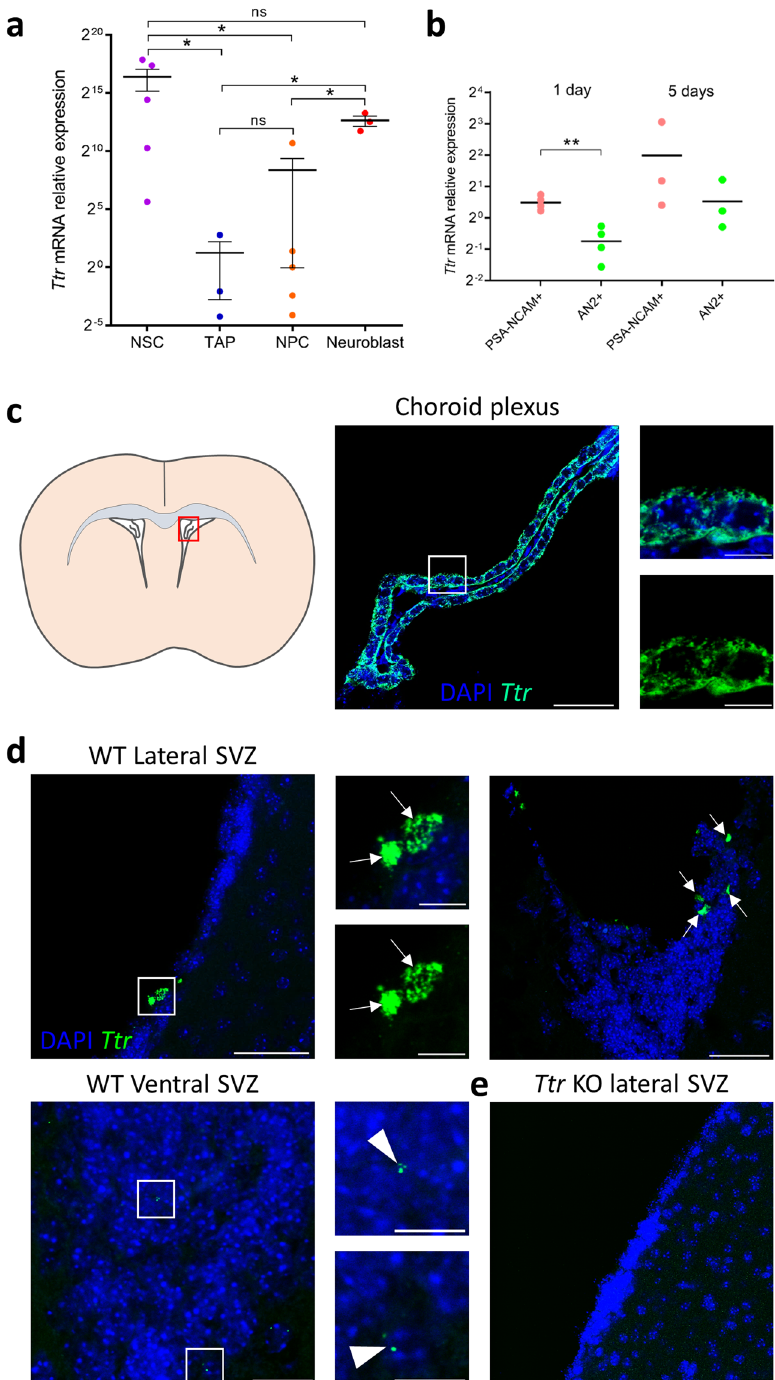
Figure 5. Detection of Ttr mRNA expression in SVZ cells. ( a ) Ttr mRNA expression levels in FACS-sorted SVZ cells. High Ttr levels were found in quiescent and activated NSCs (CD133 + ), after which they dropped in TAPs (EGFR + ) and NPCs (EGFR + CD24 + ). Cells committed to the neuroblast lineage (CD24 + ) showed increased Ttr expression levels (n = 3–5, Kruskal Wallis ANOVA followed by Mann-Whitney U tests). ( b ) Ttr mRNA expression levels were measured in magnetic bead-sorted neuronal (PSA-NCAM + ) and oligodendroglial (AN2 + ) cells after 1 and 5 days of in vitro differentiation. Ttr mRNA levels were significantly higher in neuronal cells after 1 day of in vitro differentiation (n = 3–4, two-tailed Student’s T tests). ( c ) Visualisation of Ttr mRNA transcripts in choroid plexus epithelial cells (red box on the schematic section) using RNAscope. Ttr mRNA transcripts (green dots, magnification of the white box) are abundantly present in the cytoplasm surrounding the nuclei (blue). Scale bar left picture: 50 µ m, inserts: 10 µ m. ( d ) Representative pictures of the lateral and ventral SVZ of WT mice (n = 4) showing few cells with a high number of Ttr mRNA transcripts (white arrows, magnification of white boxe), and some cells with a